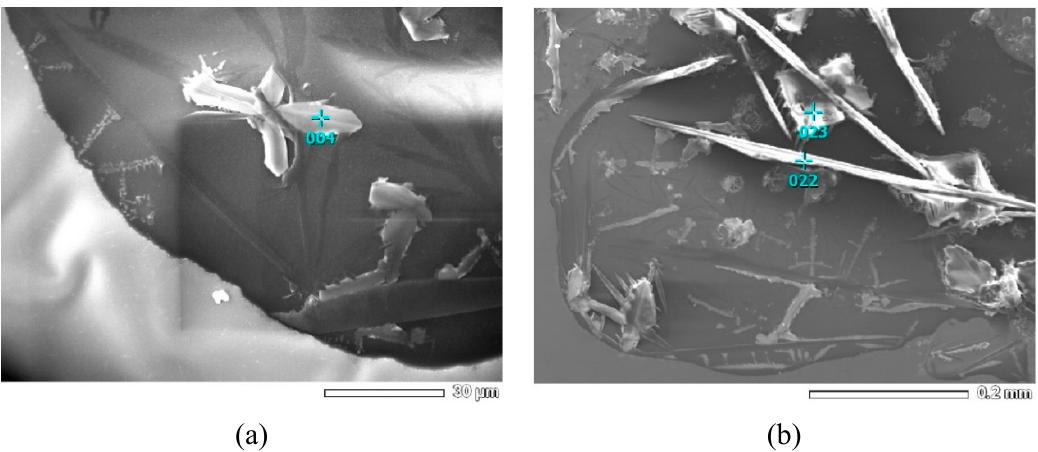
Figure 14. Observed crystal substances: ( a ) feather-like and ( b ) needle-like and square shape. Table 6. The energy disperse spectroscopy (EDS) analysis results of different crystals on aggregate